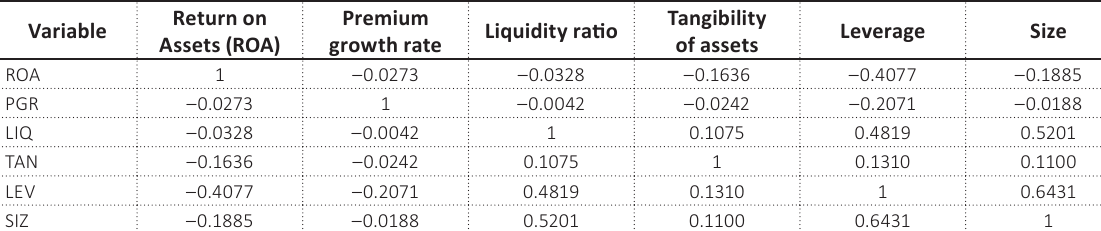
Table 3. Results of Pearson’s